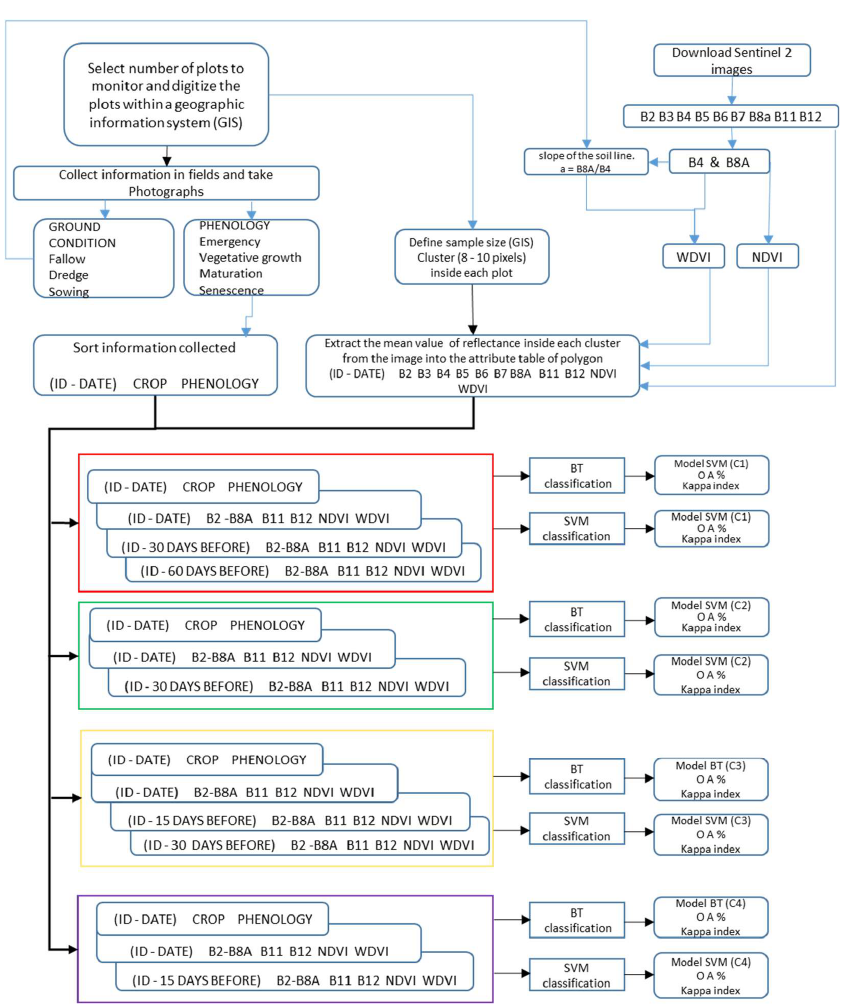
Figure 1. General overview of the methodology used to obtain the models for crop mapping.